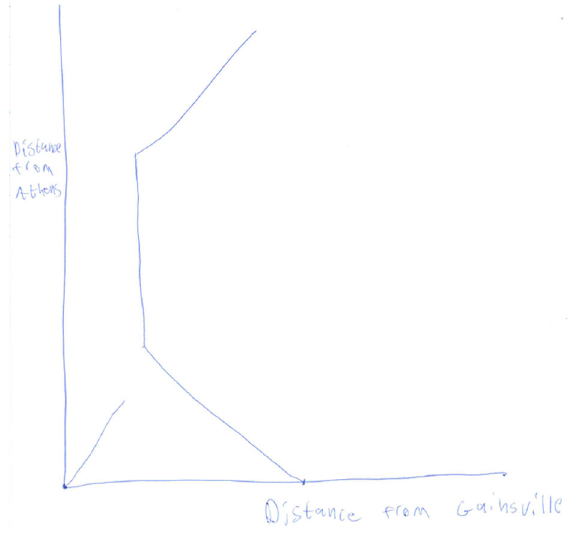
Figure 9. Wesley’s graph comparing the distance from Athens to the distance from Gainesville